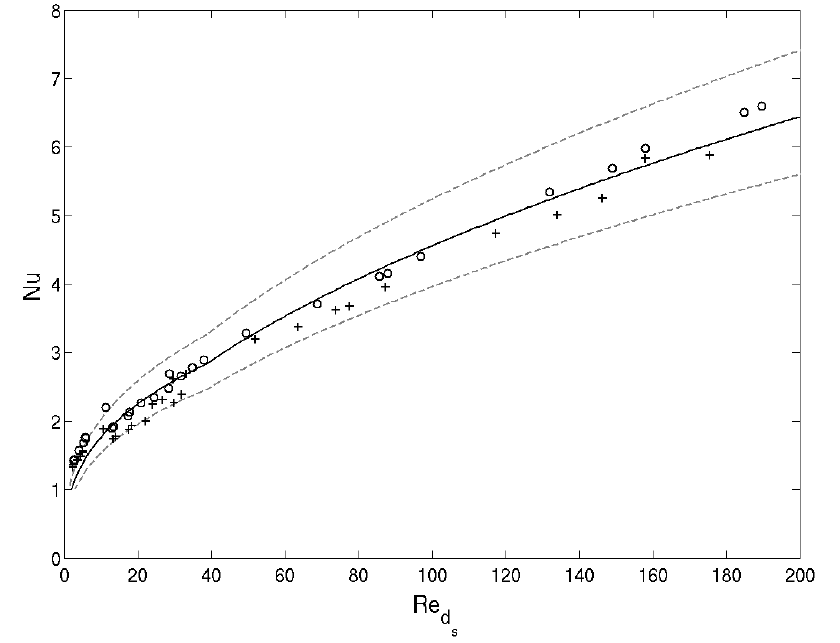
Figure 11. Validation of the interstitial heat transfer coefficient. The symbols + and ◦ represent respectively the Nu x and Nu y results. The solid line gives correlation (28) [38]. The dashed lines indicate ± 15%